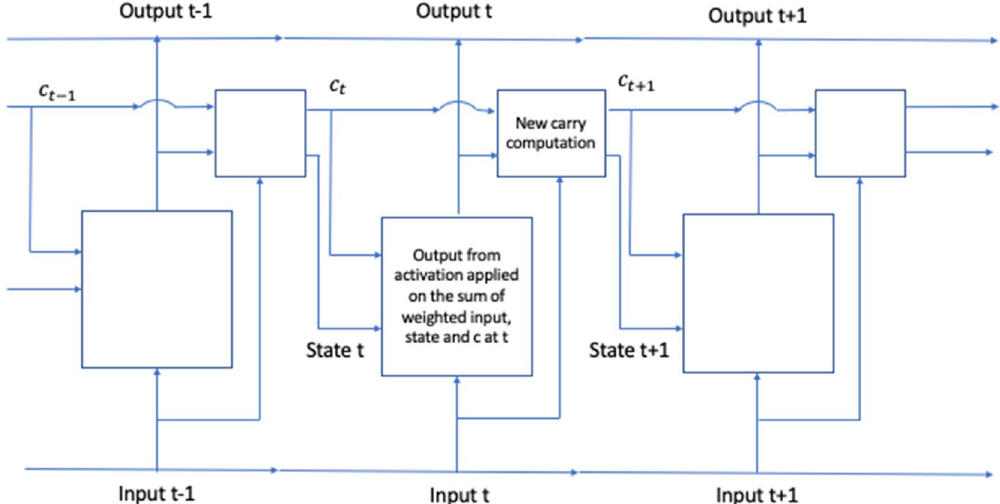
Figure 2. We used RNN with LSTM 17–20 . The LV pressure and volume from 20 previous time steps and active mechanical properties from current time step were used to predict current LV pressure and volume. Also, the LV endocardium stresses from 20 previous elements as well as passive mechanical properties from current time step were used to predict LV endocardium stresses at current time step. Here c represents carry state 19